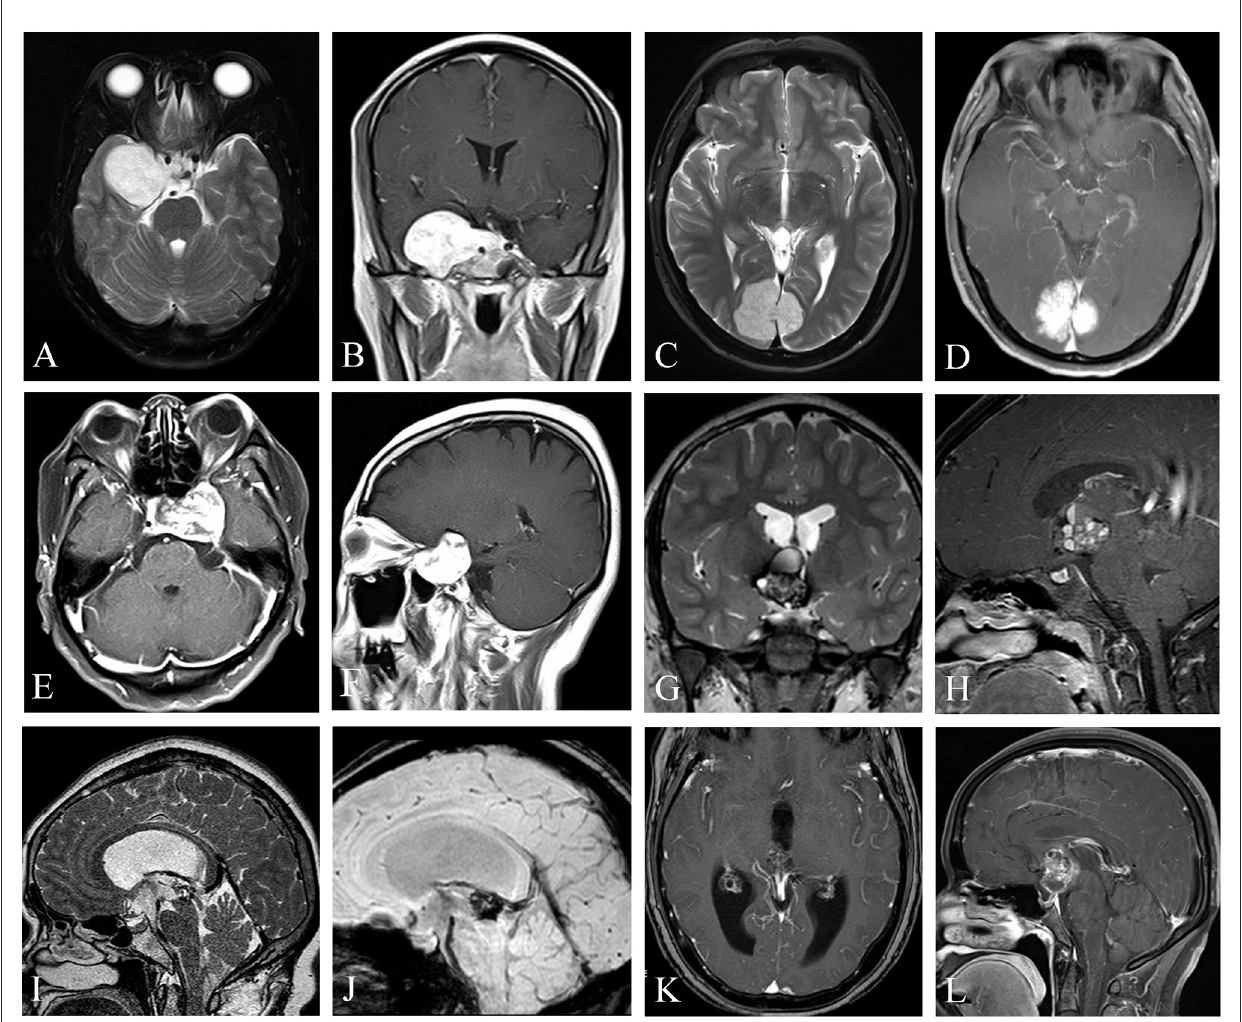
FIGURE1 Uncommon cavernous hemangiomas (UCHs) with different locations and radiological features. Case 3, a right enhanced parasellar region CH with pituitary fossa involvement and dural tail sign (A, B) , mimicking a sphenoid ridge meningioma. Case 12, a strongly enhanced CH originating from occipital falx was depicted with a dural tail sign (C, D) , masquerading as a meningioma. Case 4, a CH located at the sellar or parasellar region, mimicking a meningioma (E, F) . Case 10, a CH located in the third ventricle, with classic popcorn-like radiological features, with a hypointense rim on T2-weighted image (G) and heterogenous enhancement (H) . Case 11, a CH located at the inlet of midbrain aqueduct (I–K) , with susceptibility-weighted imaging (J) showing hemosiderosis deposition of the lesion, indicating a diagnosis of a CH. Case 6, a CH located at the suprasellar region mimicking a craniopharyngioma (L) . (I–K) Demonstrated in Neurosurgical Focus Video— Anterior endoscopic transcortical approach to a pineal region cavernous hemangioma